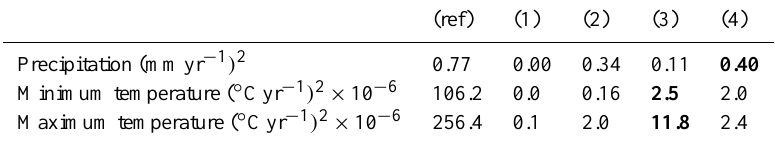
Table 3. Variance of Annual Sen’s slope spatial